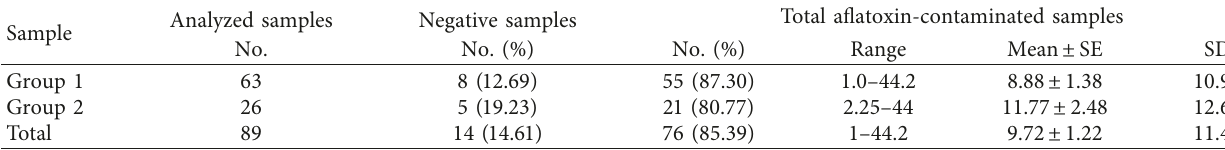
Table 4: Total aflatoxin contamination in groundnut samples.